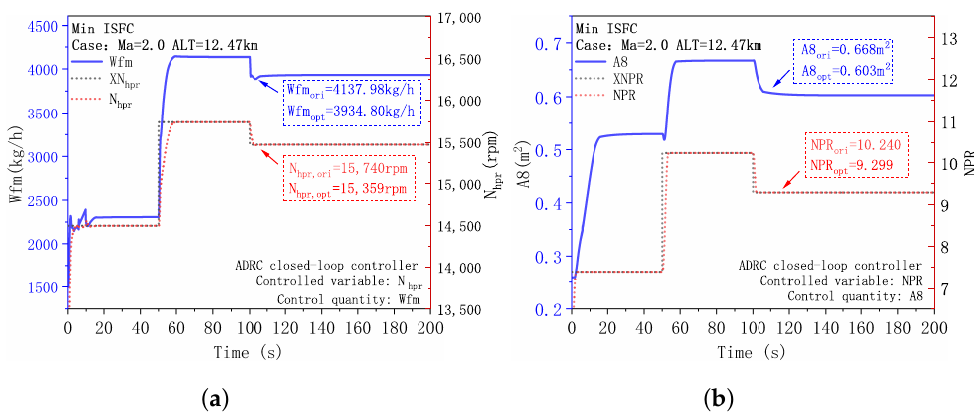
Figure 14. ( a ) Dynamic analysis of the controlled variables wfm and N hpr under Min ISFC mode. ( b ) Dynamic analysis of the controlled variables A8 and NPR under Min ISFC mode.